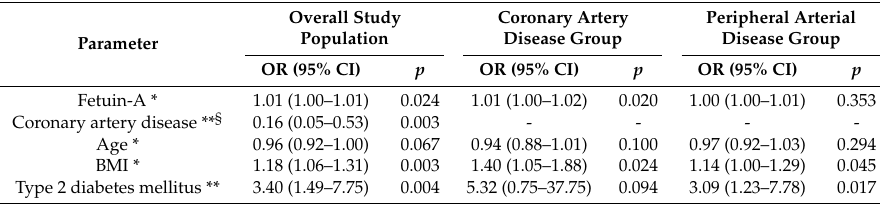
Table 3. Multivariate analysis exploring factors associated with NAFLD.